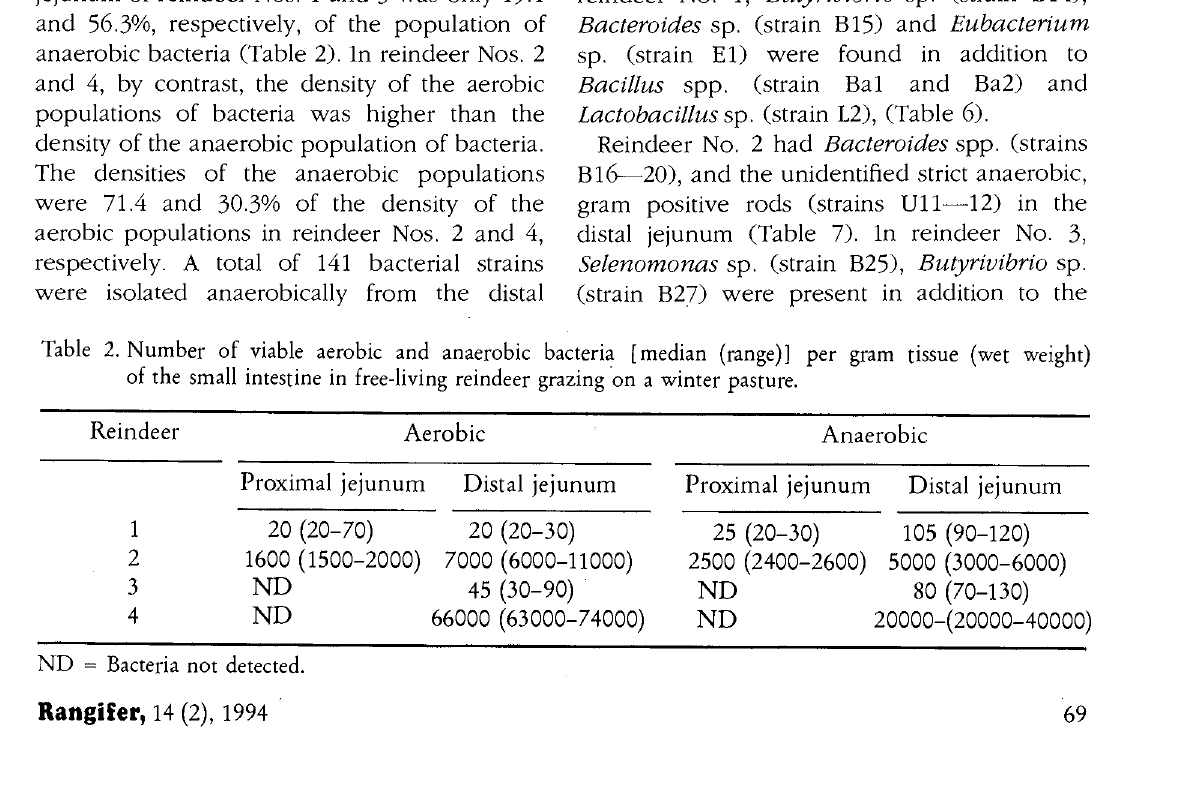
Table 2. Number of viable aerobic and anaerobic bacteria [median (range)] per gram tissue (wet weight) of the small intestine in free-living reindeer grazing on a winter pasture.